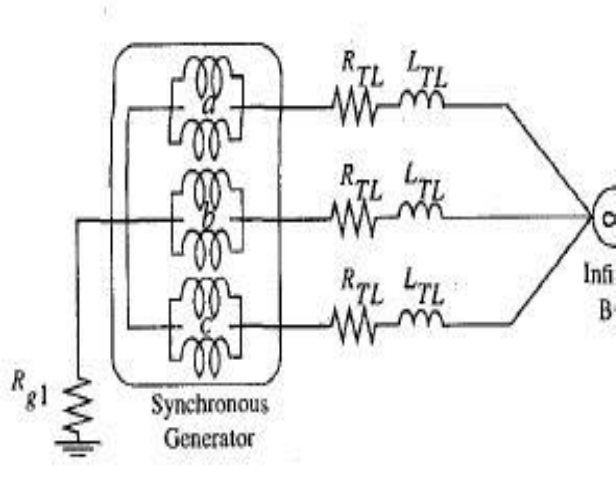
Figure 1 . Synchronous Generators with Infinite